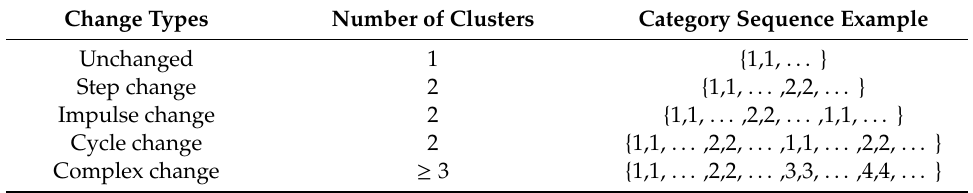
Table 1. The corresponding relation between di ff erent change types and category